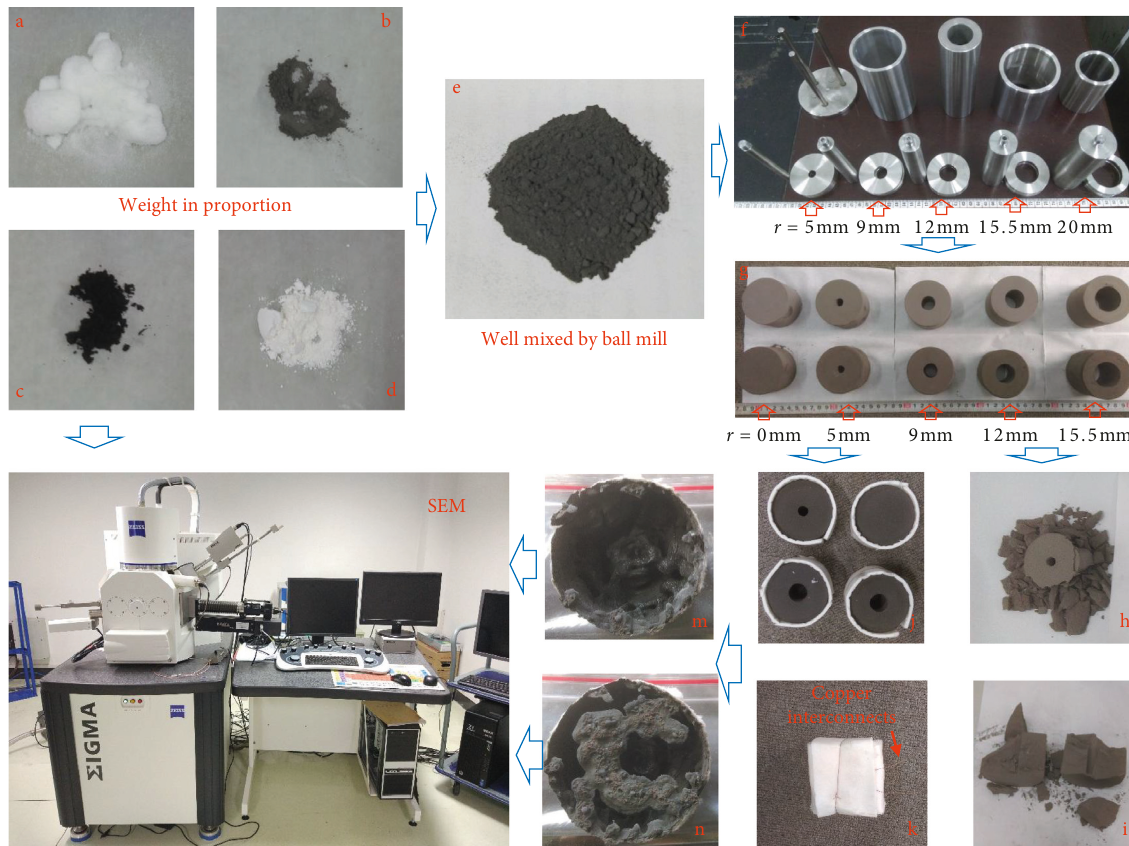
Figure 4: The process of experiments: (a) sodium chlorate; (b) Mn powder; (c) cobalt(II,III) oxide; (d) kaolin; (e) well-mixed powder of the oxygen candles; (f) mold manufactured; (g) oxygen candles at different r ; (h) axial compressive strength test; (i) radial compressive strength test; (j, k) wrapping of the OCBs; (m, n) the oxygen candles after combustion.